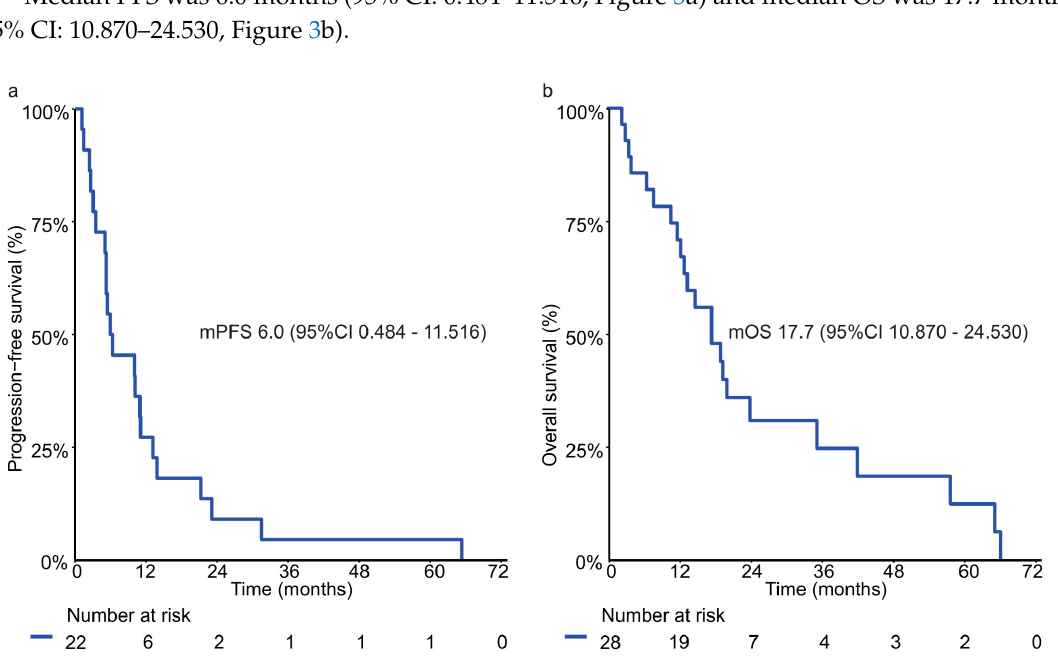
Figure 3. Progression-free survival ( a ) and overall survival ( b ) with palliative first-line trastuzumab based systemic therapy in centrally HER2 positive advanced gastric/GEJ cancer patients. The tick marks on the curves represents censored patients.